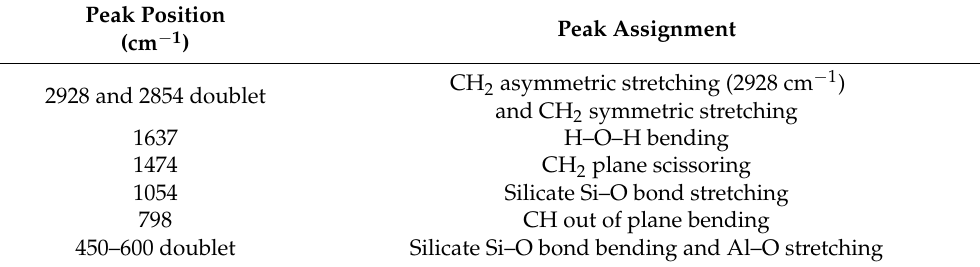
Figure 3. ( a ) Quaternary ammonium cation in 20 A clay gallery, where HT is hydrogenated tallow; the anion is Cl − . ( b ) FTIR spectra of PANi, clay, and PACN. Table 1. Summary of FTIR absorption peaks of CLOISITE ® 20 A clay.